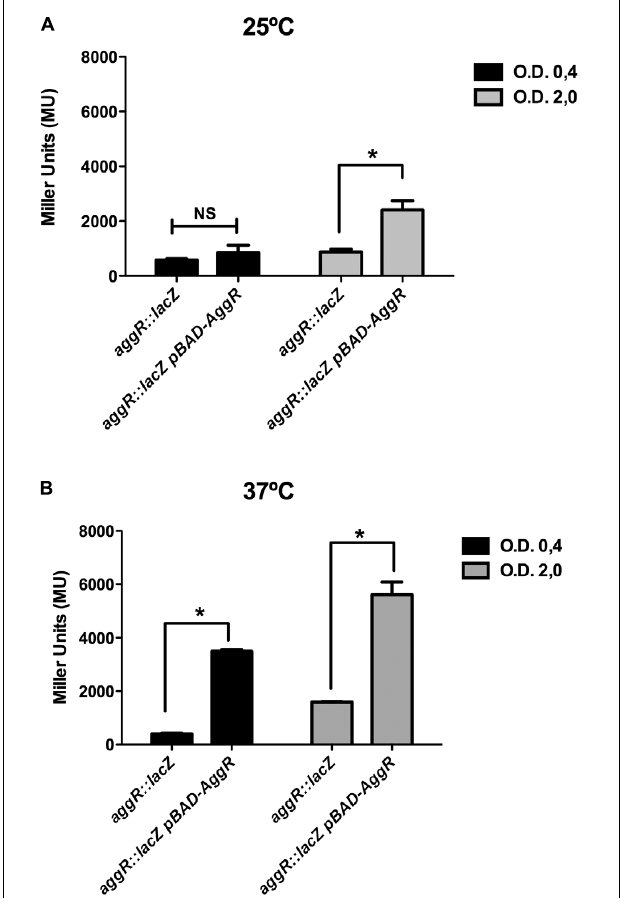
FIGURE 1 | Effect of growth phase and temperature on aggR expression in strain 042. (A) β -Galactosidase activity in strain 042 cultures grown in LB medium with 0.45% of L -arabinose and collected at the exponential and early stationary growth phases. Cultures were grown at 25 (A) and 37 ◦ C (B) . Strain used was 042LCaggRLacZ without and with pBAD-AggR plasmid. Transformation of strain 042LCaggRLacZ with pBAD18 plasmid (empty vector) did not modify β -galactosidase activity. The data shown are the means and standard deviations of three independent experiments. Statistical analysis showed significative difference compared to the control ( ∗ P -value < 0.0001; NS,